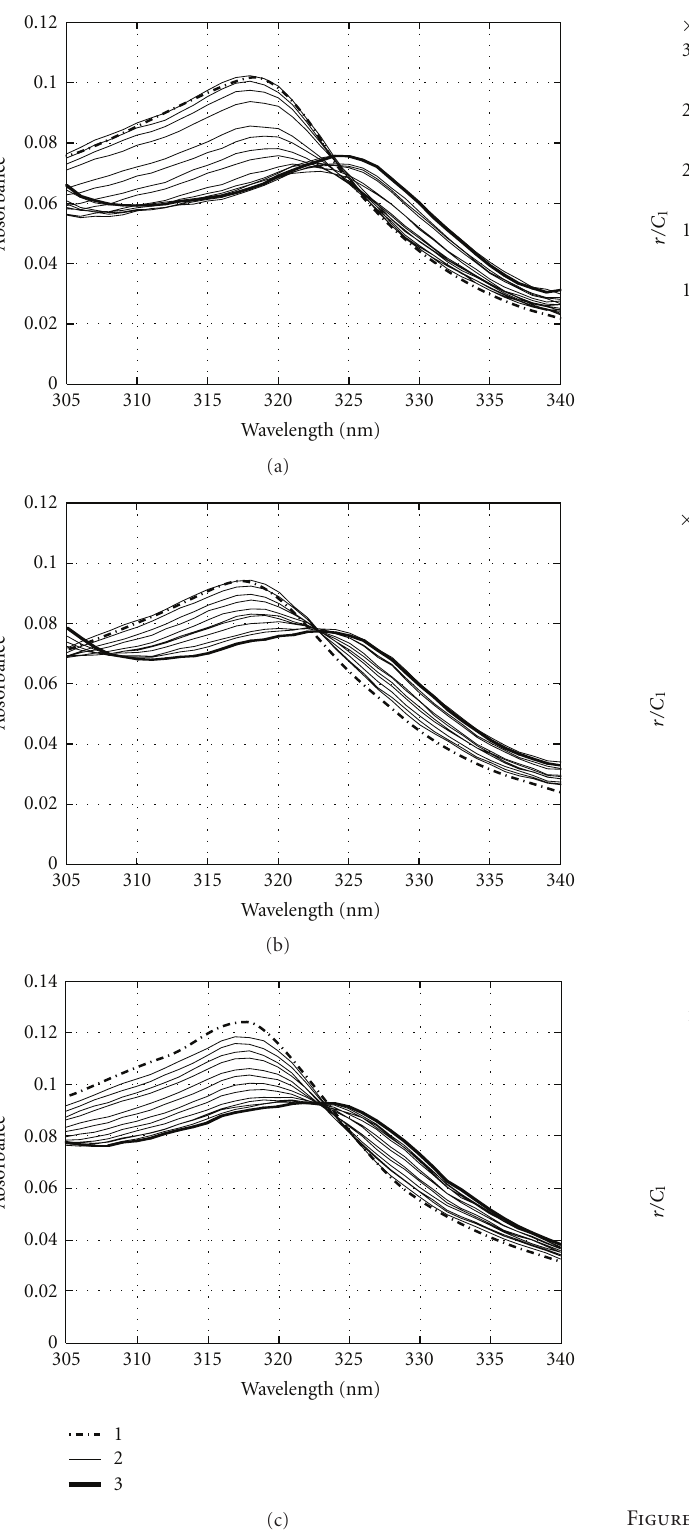
Figure 2: UV absorption spectra of AIC:DNA complexes: (a) AIC:G-c- Myc , (b) AIC:G-tel, and (c) AIC:c- Myc duplex. The concentrationsof oligomersPu18 and d(TTAGGG)4 were 0–2.5 μ M (strands) and of c- Myc duplex were 0–3 μ M (strands). Curves 1– 3 indicate the spectra of free AIC, partially bound AIC and fully bound AIC, respectively: Hanks’ bu ff er, t = 20 ◦ C.